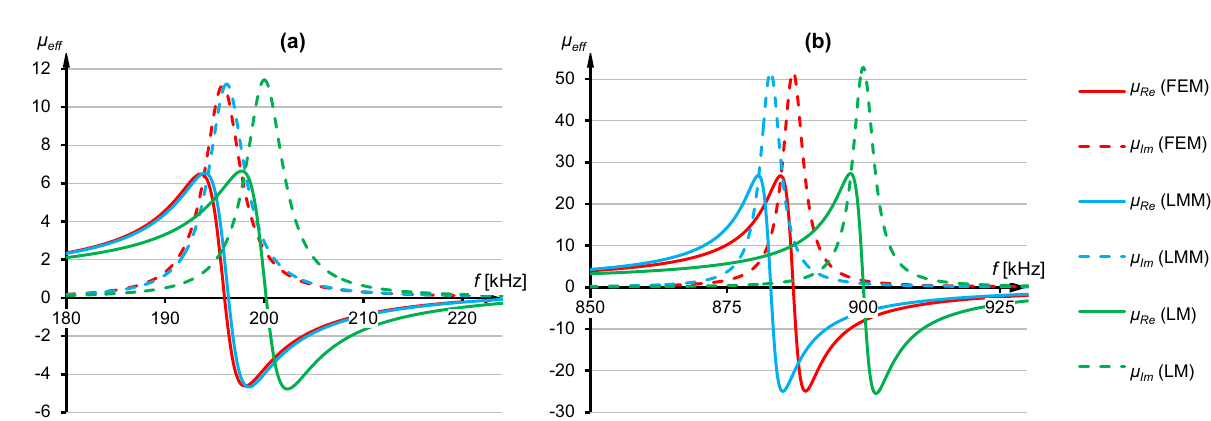
Figure 4. Real and imaginary parts of the effective permeability obtained using three models at h = d w , for the specified resonant frequencies: ( a ) f z = 200 kHz. ( b ) f z = 900